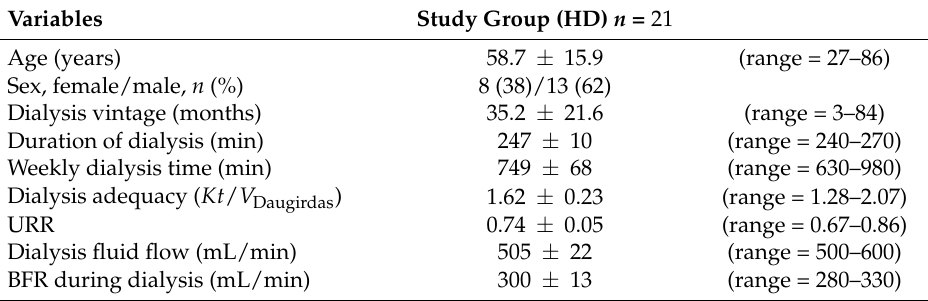
Table 1. Baseline characteristics of the patients participating in the study ( n =